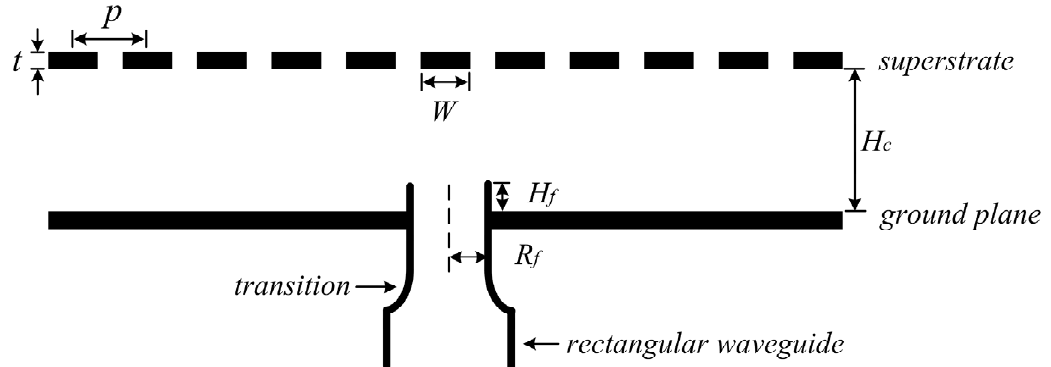
Figure 3. Cross ‐ section of the FPRA with a planar superstrate.